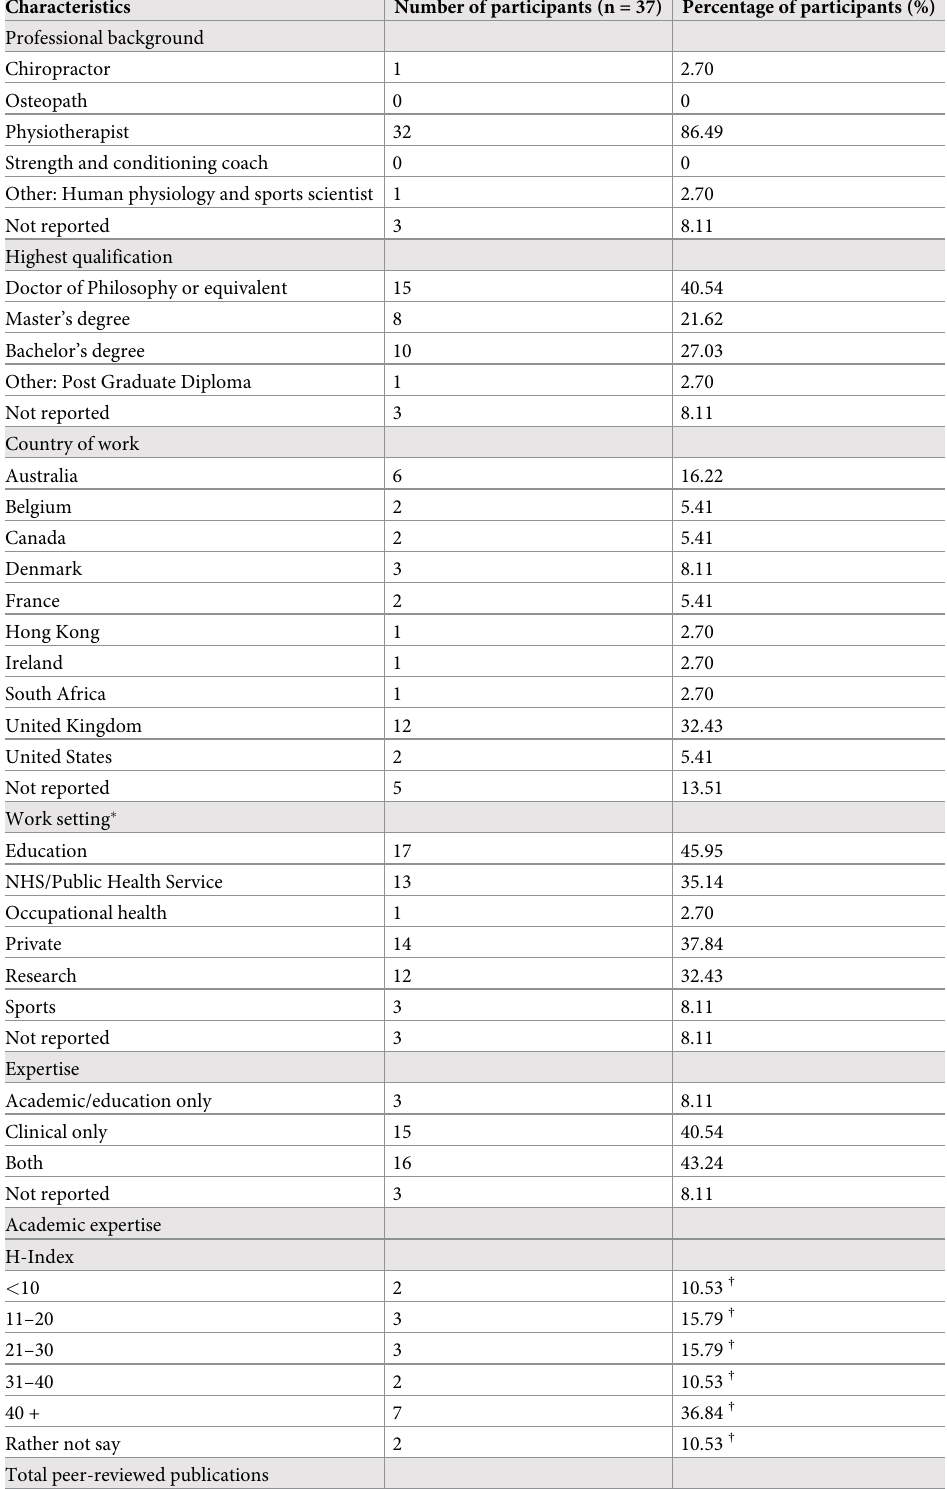
Table 1. Demographic details of participants.